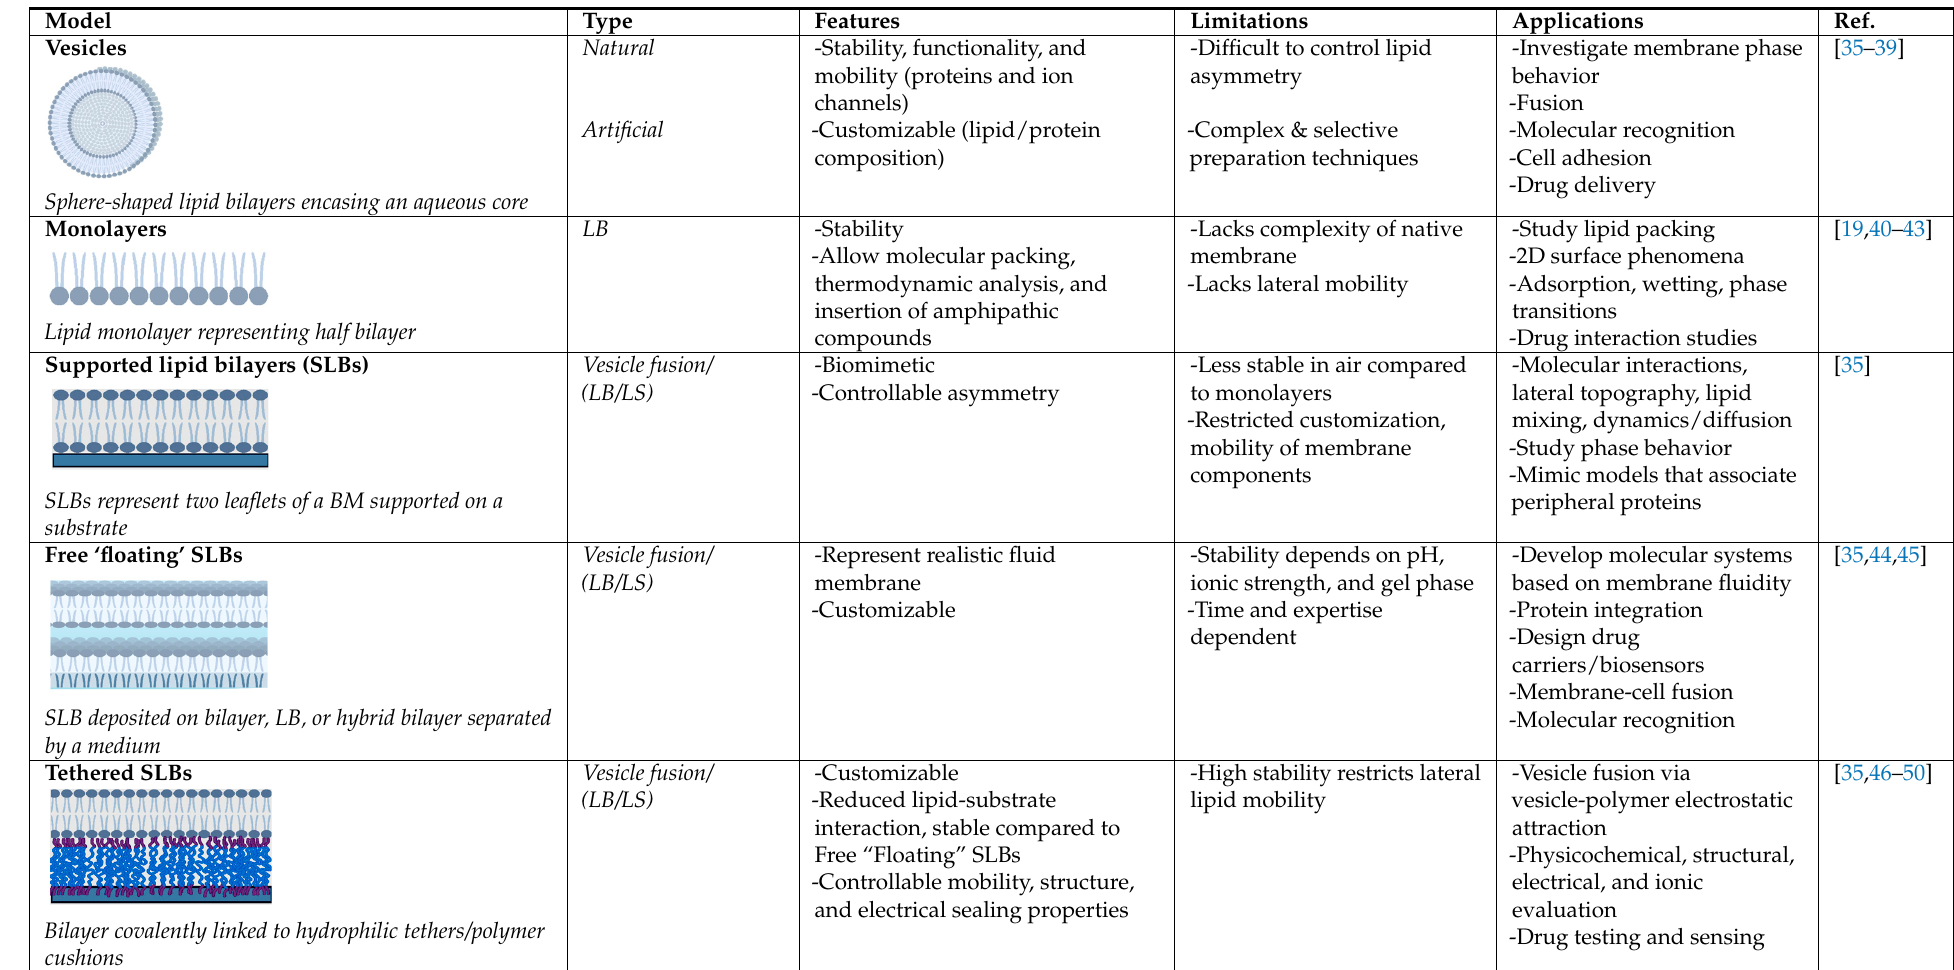
Table 1. Structure, description, features, and applications of biomimetic membranes. [Langmuir–Blodgett (LB), Langmuir–Schaefer (LS)].